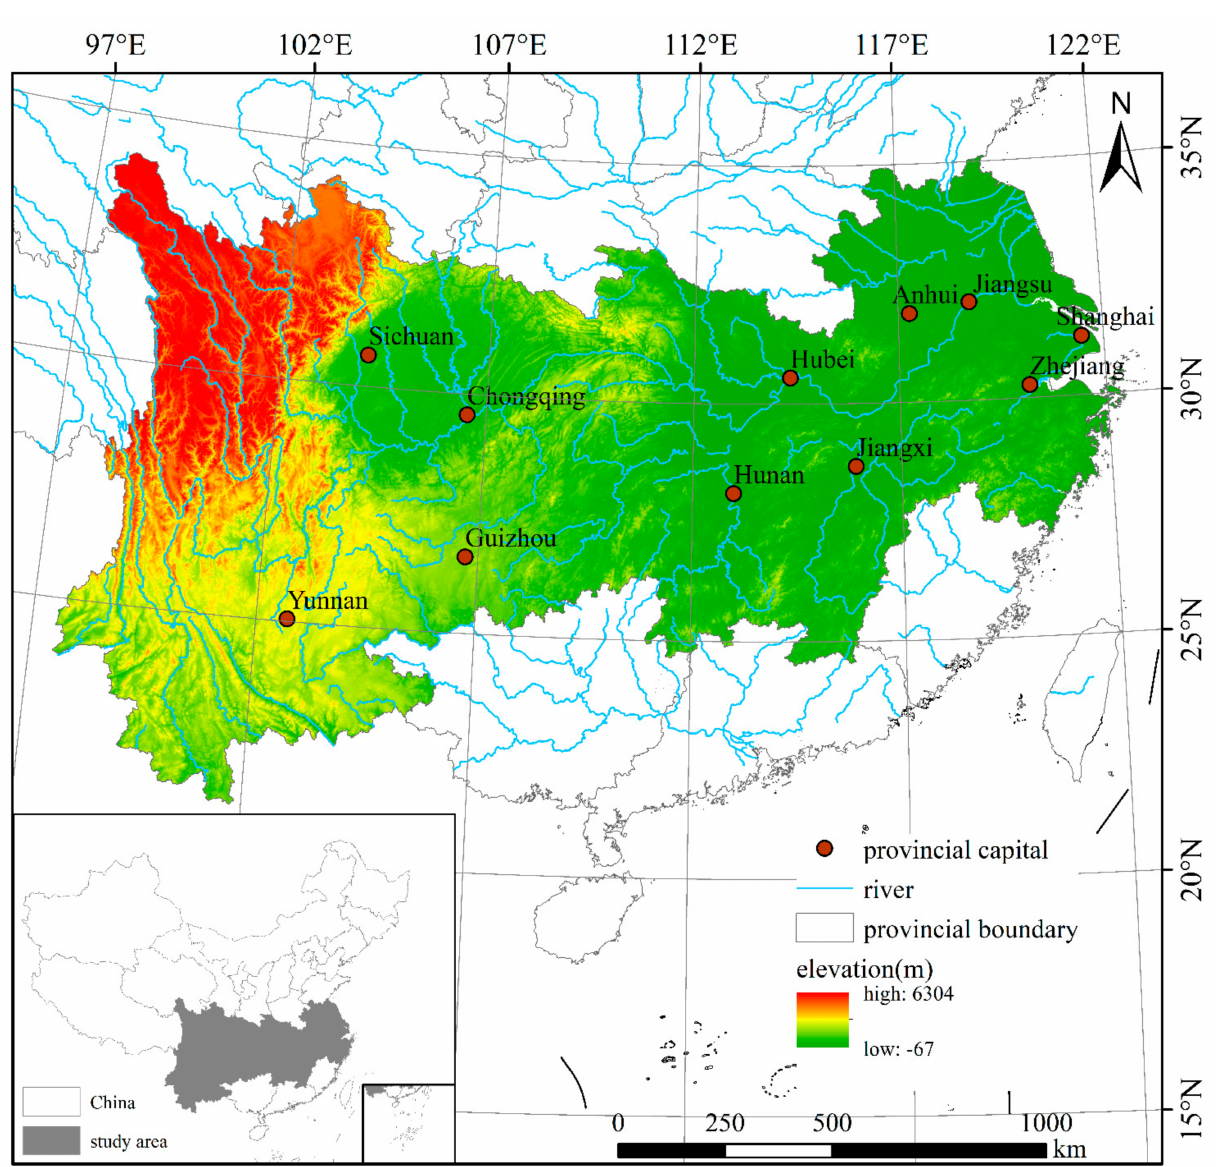
Figure 1. The Yangtze River Economic Belt in